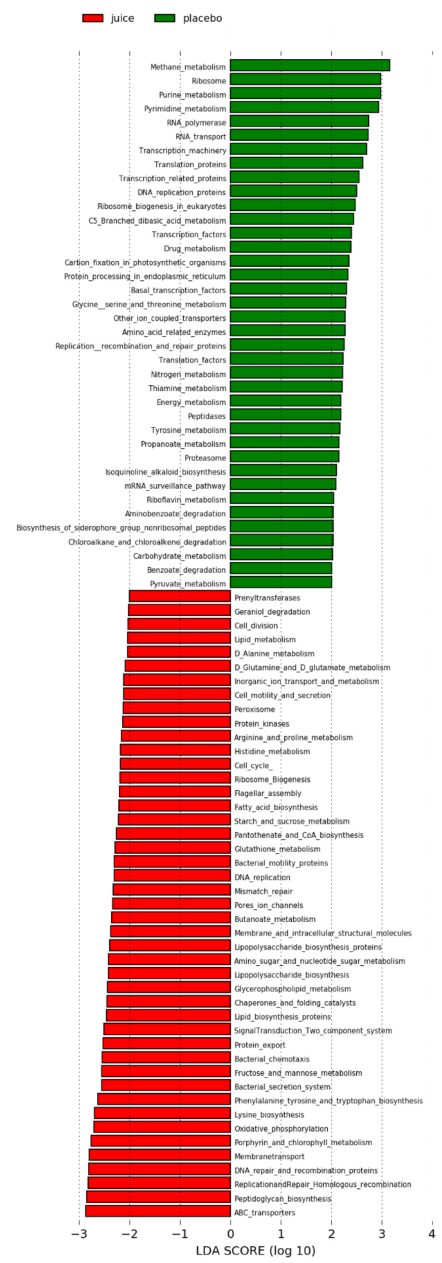
Figure 10. Predicted metabolic pathways enriched in the two groups of study at day 56 (juice and placebo) performed with PICRUSt Galaxy. Kyoto Encyclopedia of Genes and Genomes (KEGG) pathways differentially abundant in juice group (red) and placebo group (green) gut microbiota are shown. Alpha value for the factorial Kruskal–Wallis test between the two groups (juice and placebo) was set to 0.05 and a threshold on the logarithmic linear discriminant analysis (LDA) score for discriminative features was set to 2.0. All the significant features with a p -value < 0.05 are